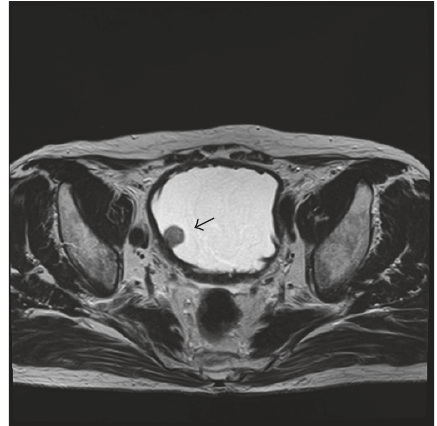
Figure 2: Pelvic MRI. Pelvic MRI T2 showed a 2.5 cm relatively homogenous mass (allow) in the right lateral bladder wall without extending base of the bladder wall.